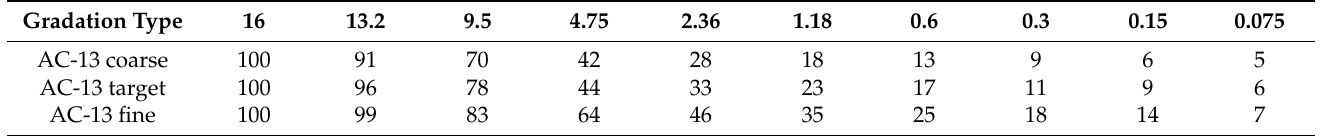
Table 2. Gradation of AC-13 asphalt mixture.